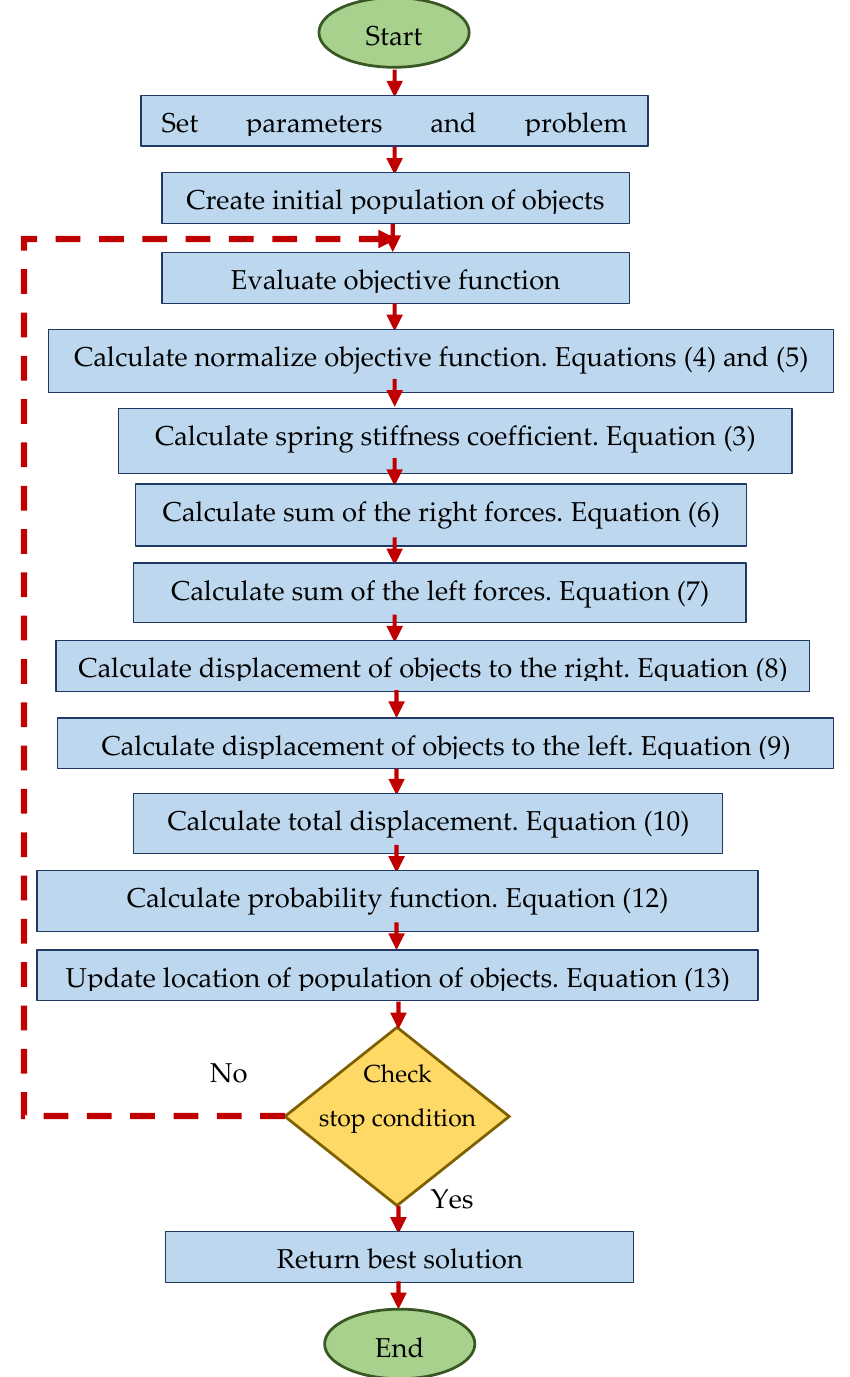
Figure 1. The flowchart of the Binary Spring Search Algorithm ( BSSA ).